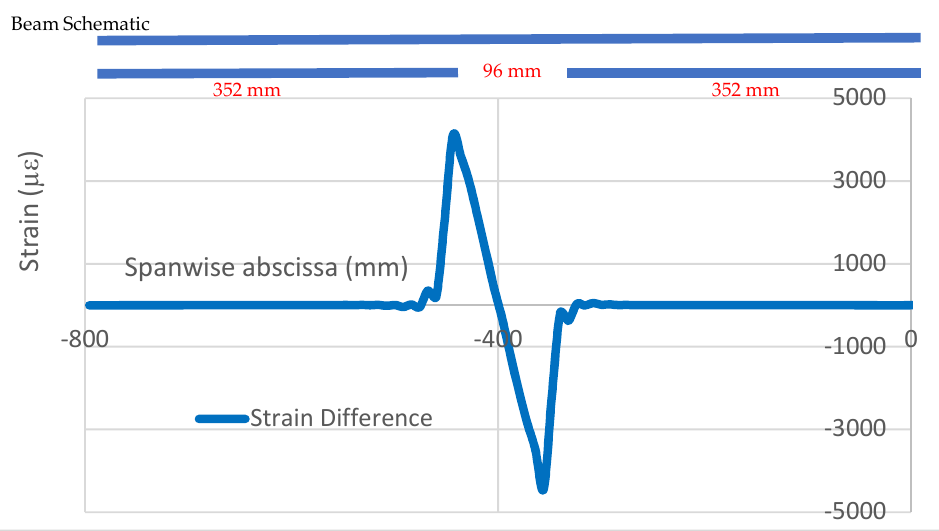
Figure 11. De-bonding effect and its localization (applied damage extension: 96 mm).